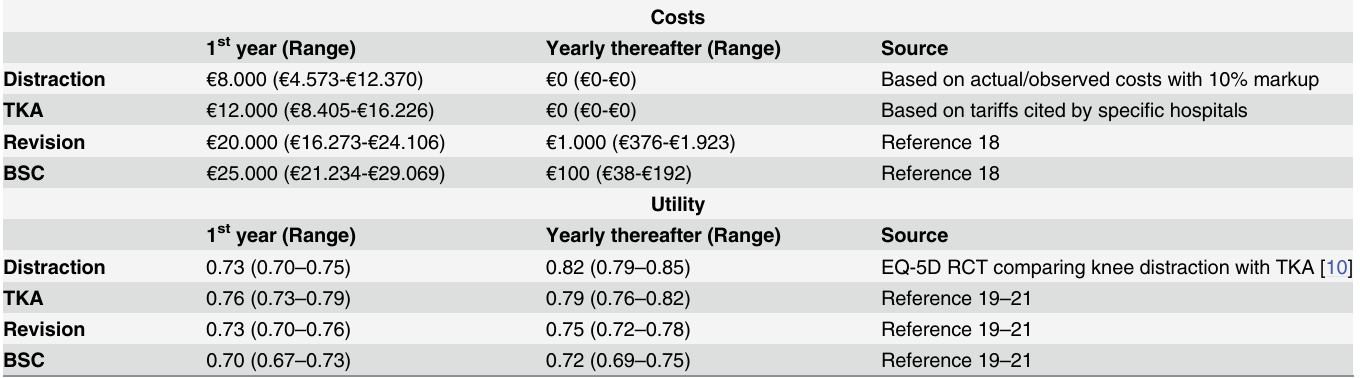
Table 2. Input data mean cost and utility per health state, point estimate with range as used in